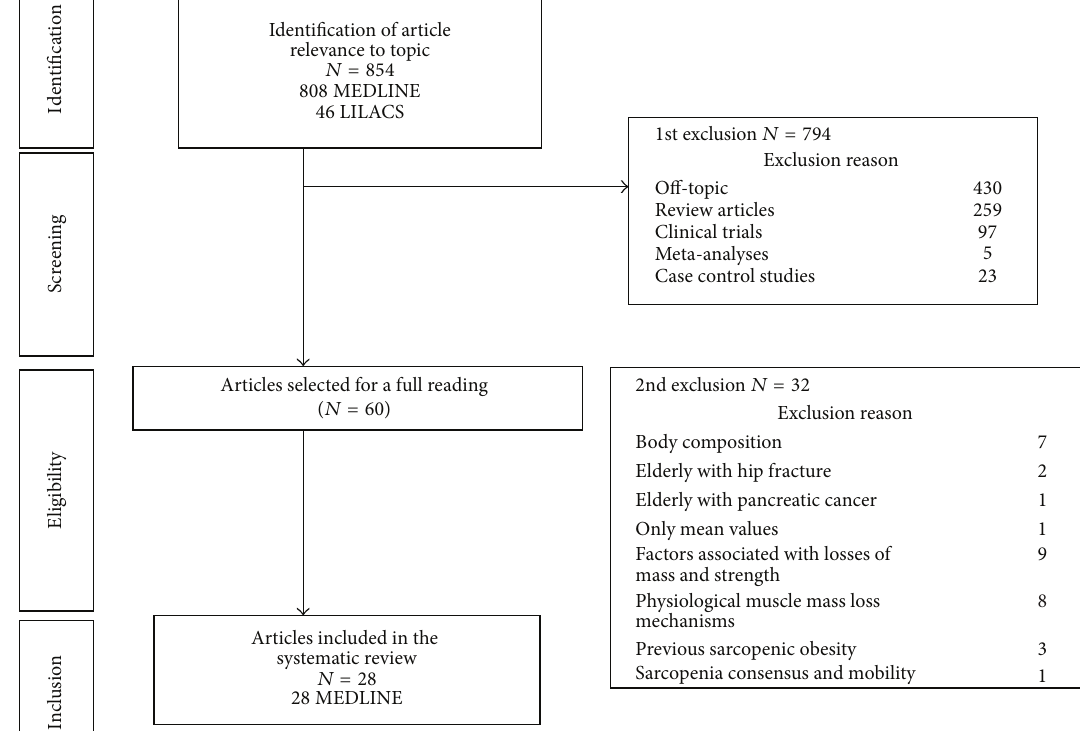
Figure 1: Flow diagram for identification, screening, eligibility, and inclusion of articles in systematic review.